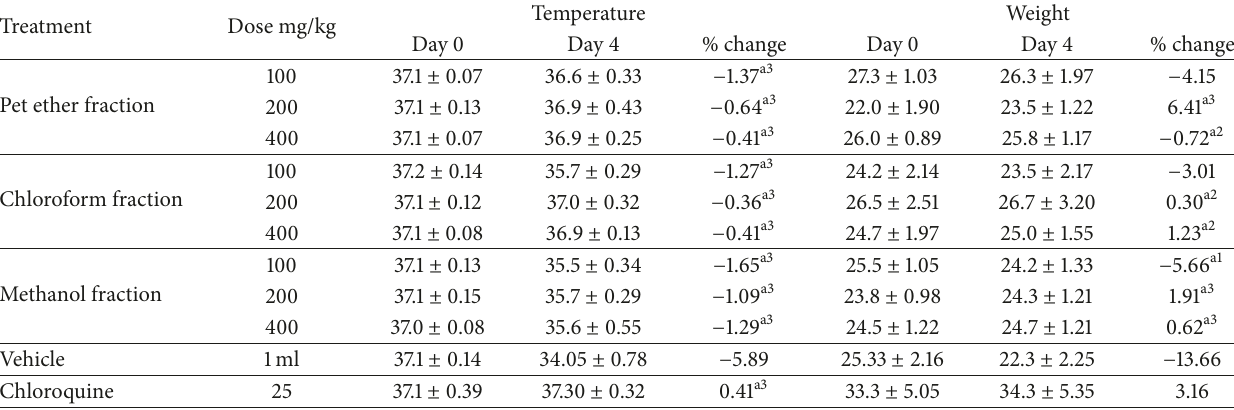
Table 4: Effect of the solvent fractions of Carica papaya rind on body temperature and weight of P. berghei infected mice on 4-day Peter’s suppression